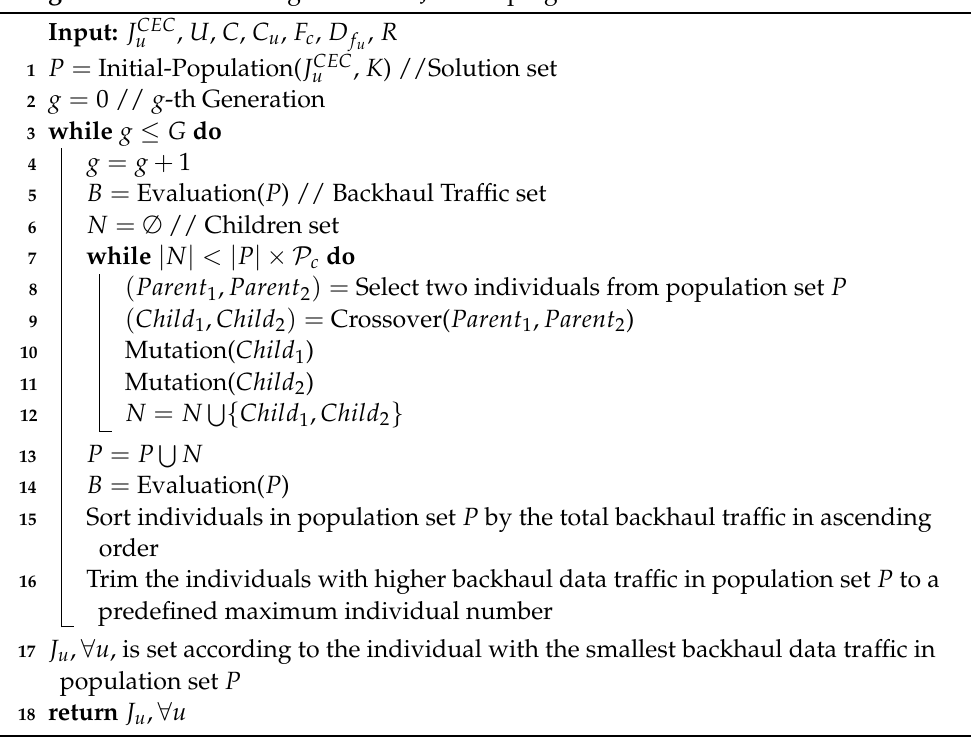
Algorithm 1: Genetic Algorithm for JT